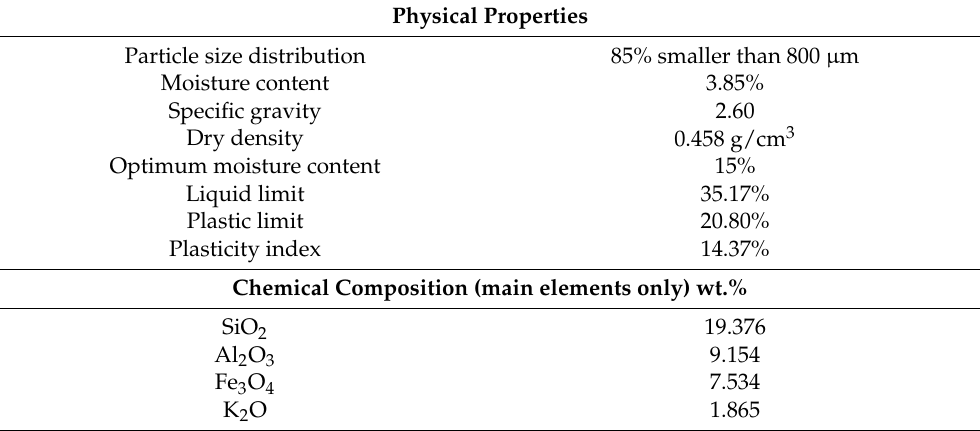
Table 1. Termite mound soil physical and chemical